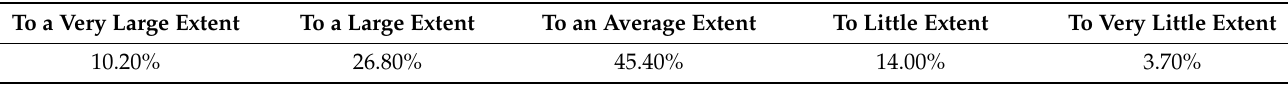
Table 8. Perceived level of knowledge. Q: To what extent do you consider yourself a well-informed person when it comes to environment and renewable energy sources?